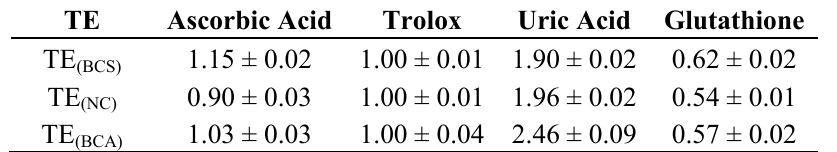
Table 1. Trolox equivalent (TE) values obtained using different copper complexing reagents.